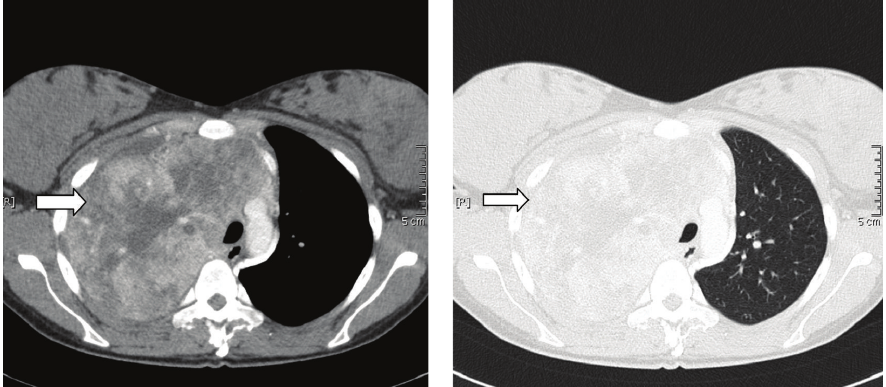
Figure 1: Contrast-enhanced computed tomography scan of a large tumor mass in the right upper lobe with extensive mediastinal infiltration.